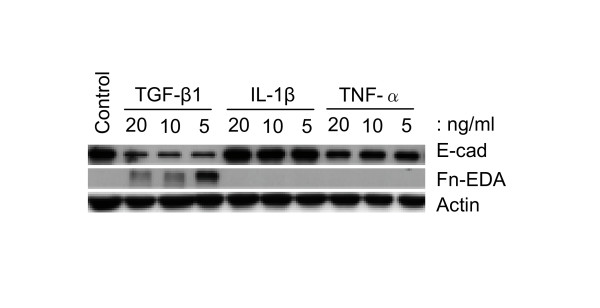
Comparison of EMT-related marker expression in response to TGF-β1, IL-1β and TNF-α treatments. A549 cells were incubated with TGF-β1, IL-1β and TNF-α at the indicated concentrations for 48 h. Only TGF-β1 decreases E-cadherin expression concomitant with increasing Fn-EDA expression. In contrast, TNF-α only slightly decreases E-cadherin expression and IL-1β has no influence on EMT-related marker expression. Equal amounts of total protein are loaded in each lane.